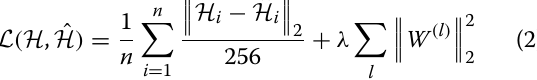
when embedded into a deep fully connected neural net- work where the learning rate is not small enough.